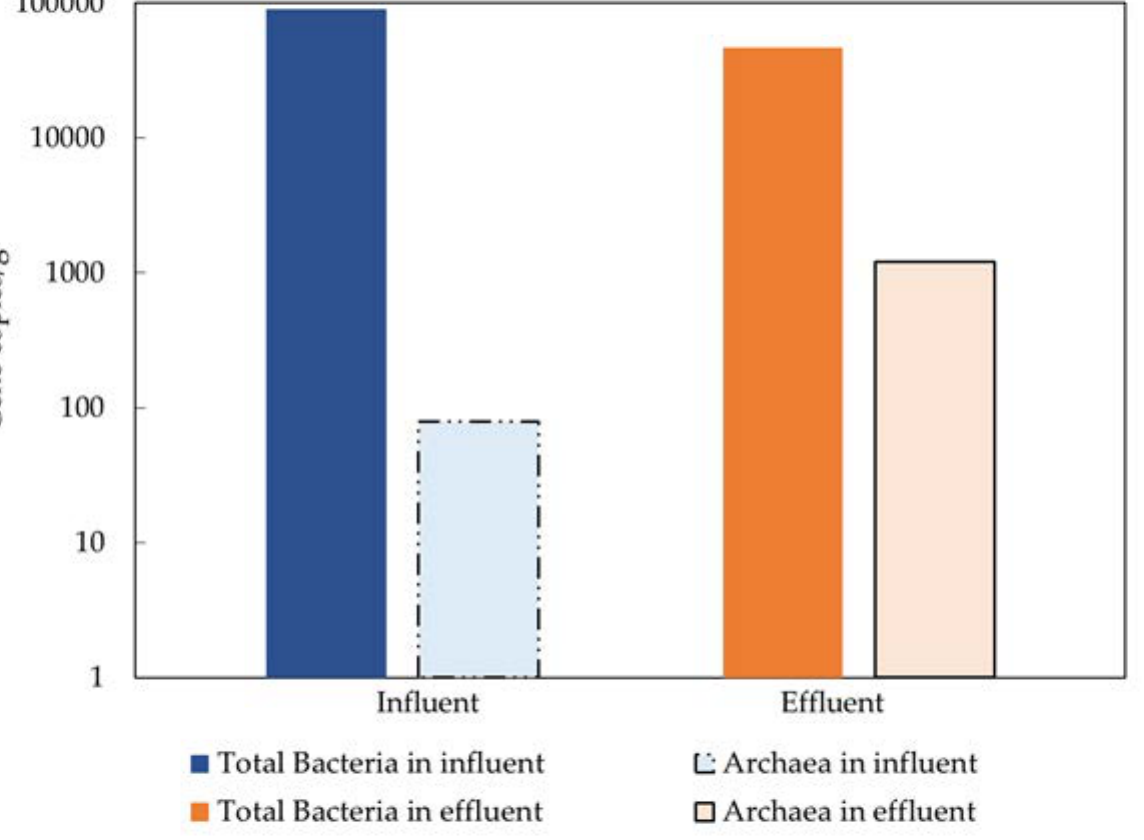
Figure 10. qPCR results for bacteria and archaea from inlet and outlet